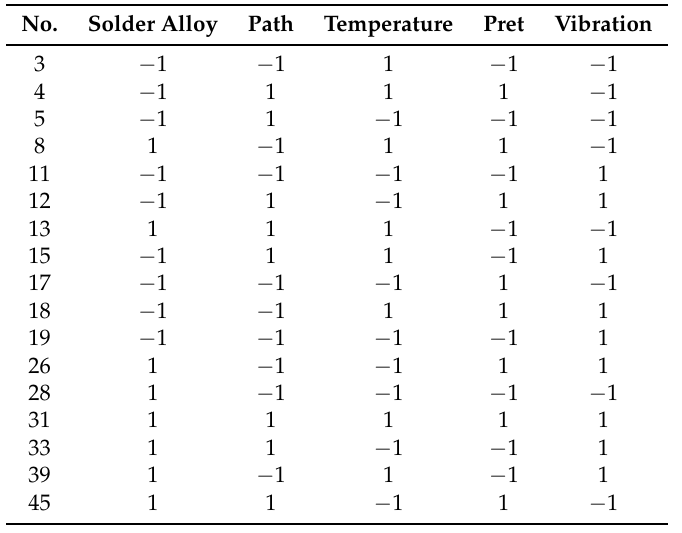
Table 1. Desing of Taguchi